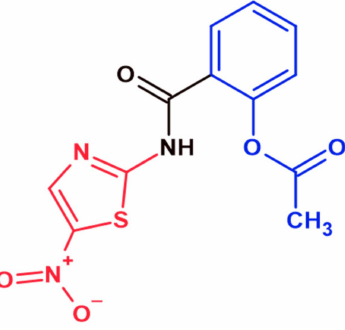
Figure 1. Nitazoxanide structure. This drug comprises two fragments, the 2-amino-5-nitrothiazole head (red color) and the acetylsalicylic tail (blue color), which are joined by an amide bridge. The chemical structure was generated with the ChemSketch program (Advanced Chemistry Development, Inc. Toronto, ON,